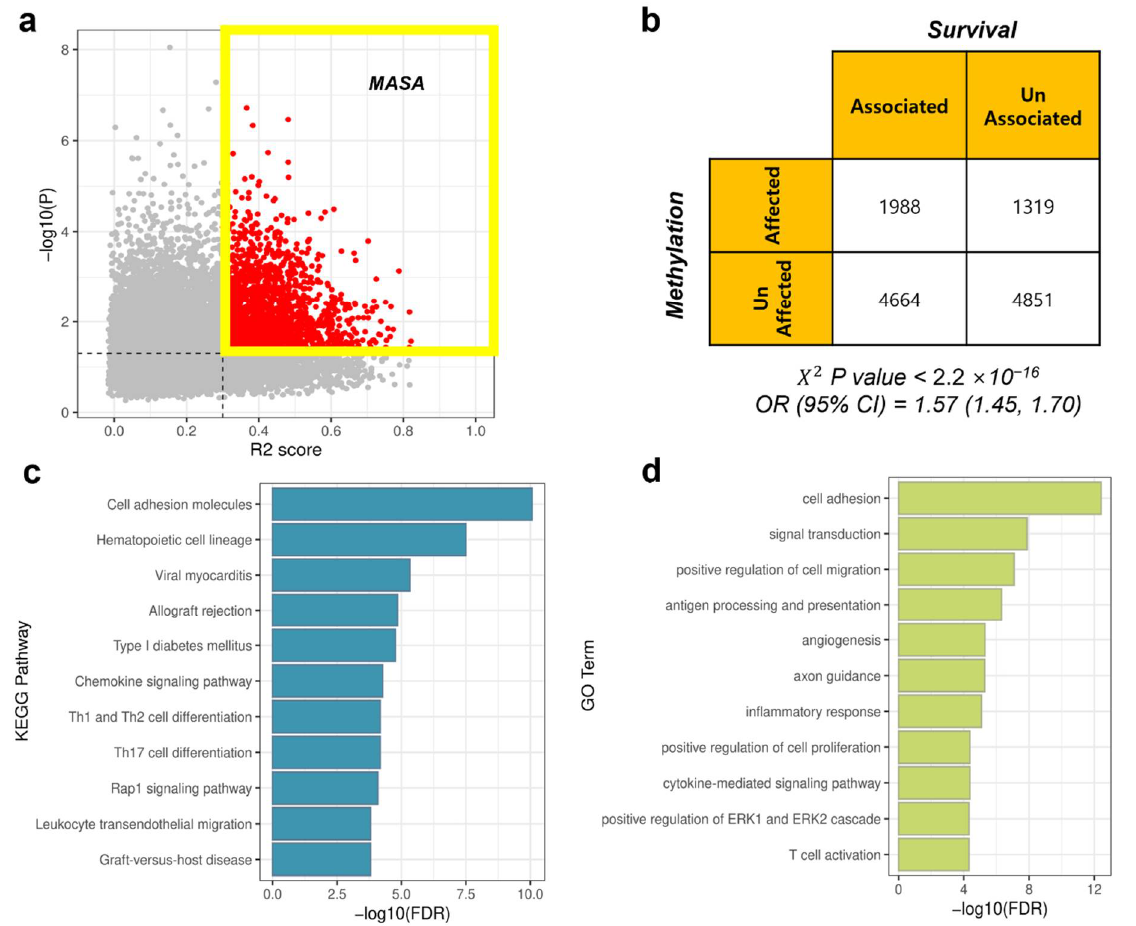
Figure 5. Analysis of MASA genes. ( a ) Comprehensive view of each gene. Red dots are MASA genes with R2 score > 0.3 and p ≤ 0.05. ( b ) Number of genes classified corresponding to each specified characteristic. ( c ) KEGG pathway enrichment analysis using MASA. ( d ) GO BP enrichment analysis using